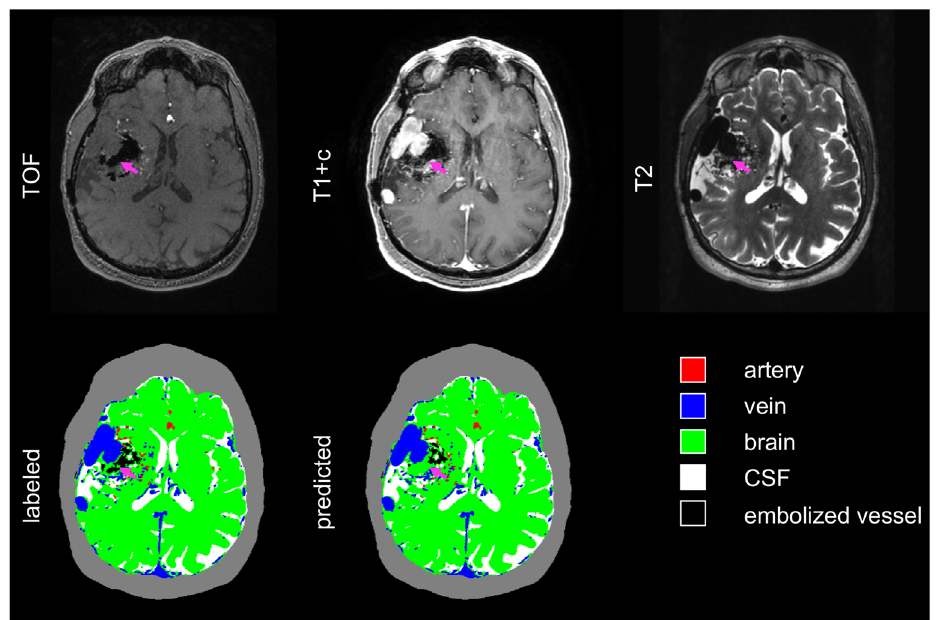
Figure 5. Representative images showing under-classification of embolized vessels within in a complex, partially embolized nidus. Purple arrows show the embolized vessels. Dice similarity coefficients for this slice are as follows: arteries 0.81; veins 0.95; brain 0.98; CSF 0.95; embolized vessels 0.64. The grey contour outlining the extracranial space is not generated by the segmentation algorithm and is included for visual reference